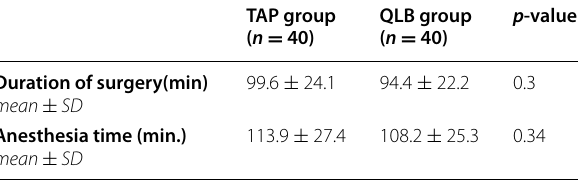
Table 2 Difference between TAP group and QLB group regarding operative and anesthetic